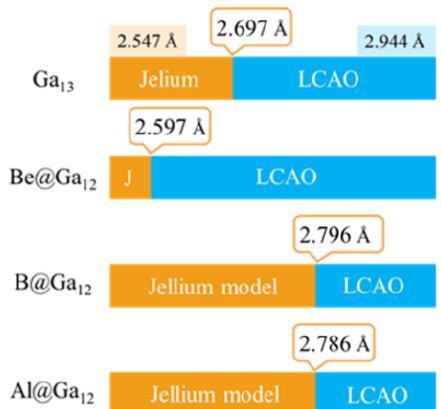
Figure 9. Boundary of the condition of the interatomic X–Ga bonding distance for Jellium model constitution of the clusters Ga 13 , Be@Ga 12 , B@Ga 12 , and Al@Ga 12 , respectively (interatomic Ga–Ga bond distance is 2.547 Å ).